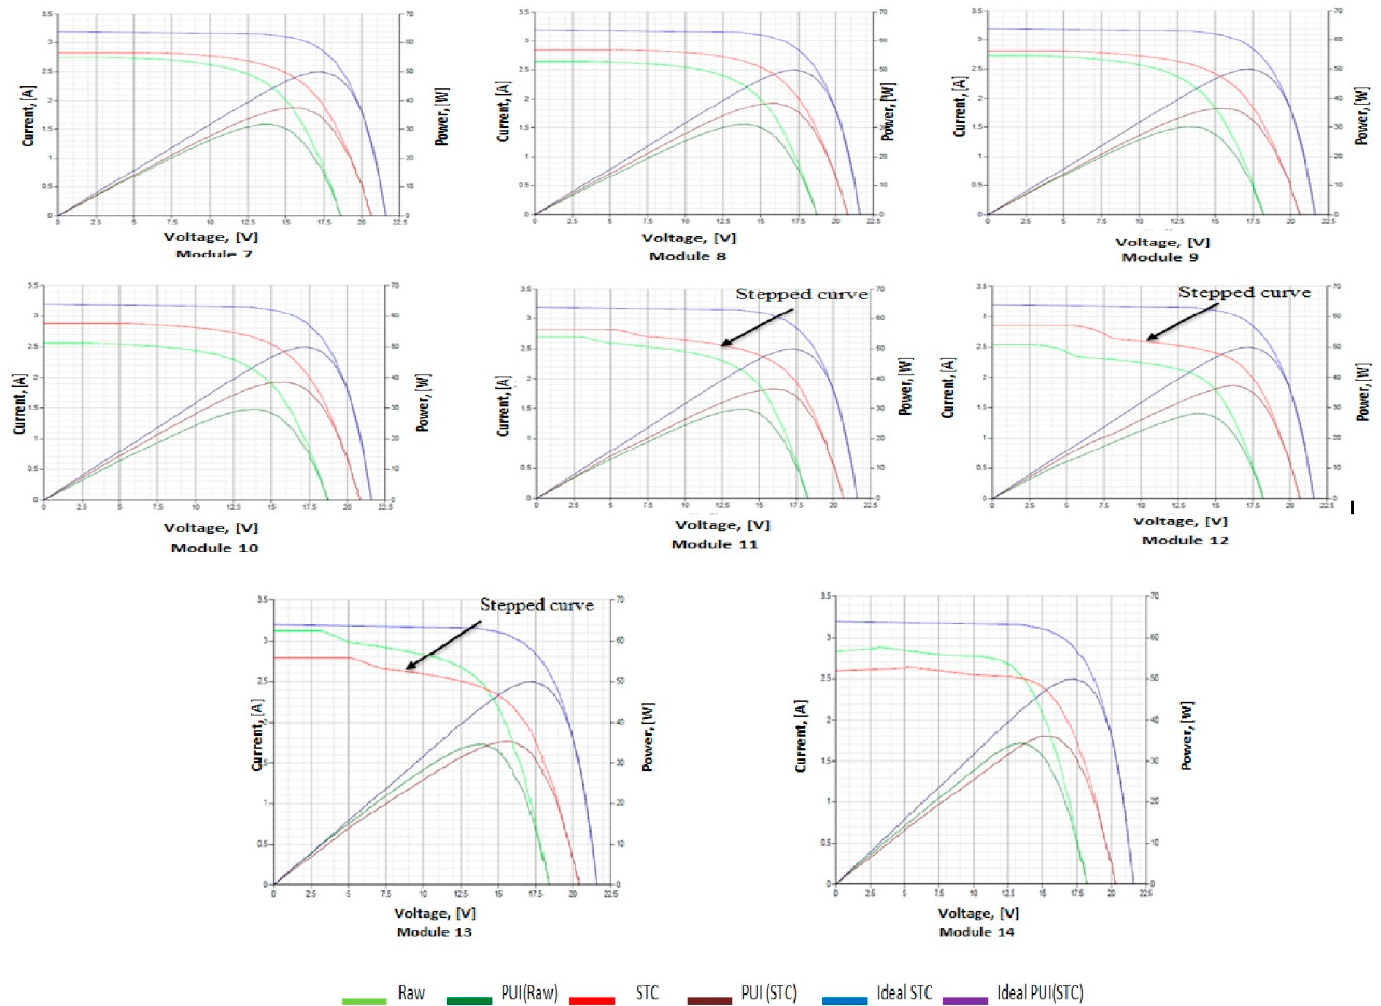
Figure 7. I-V and power graphs showing raw, extrapolated and manufactures’ Curves (Modules 1–14).